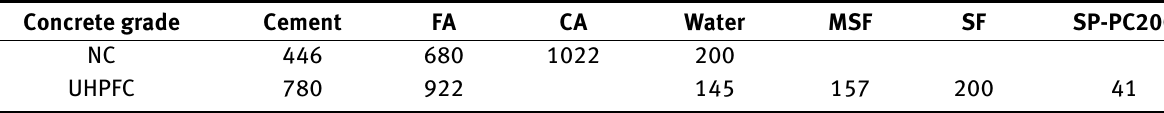
Table 2: Mix proportions of NC and UHPFC mixes, kg/m 3